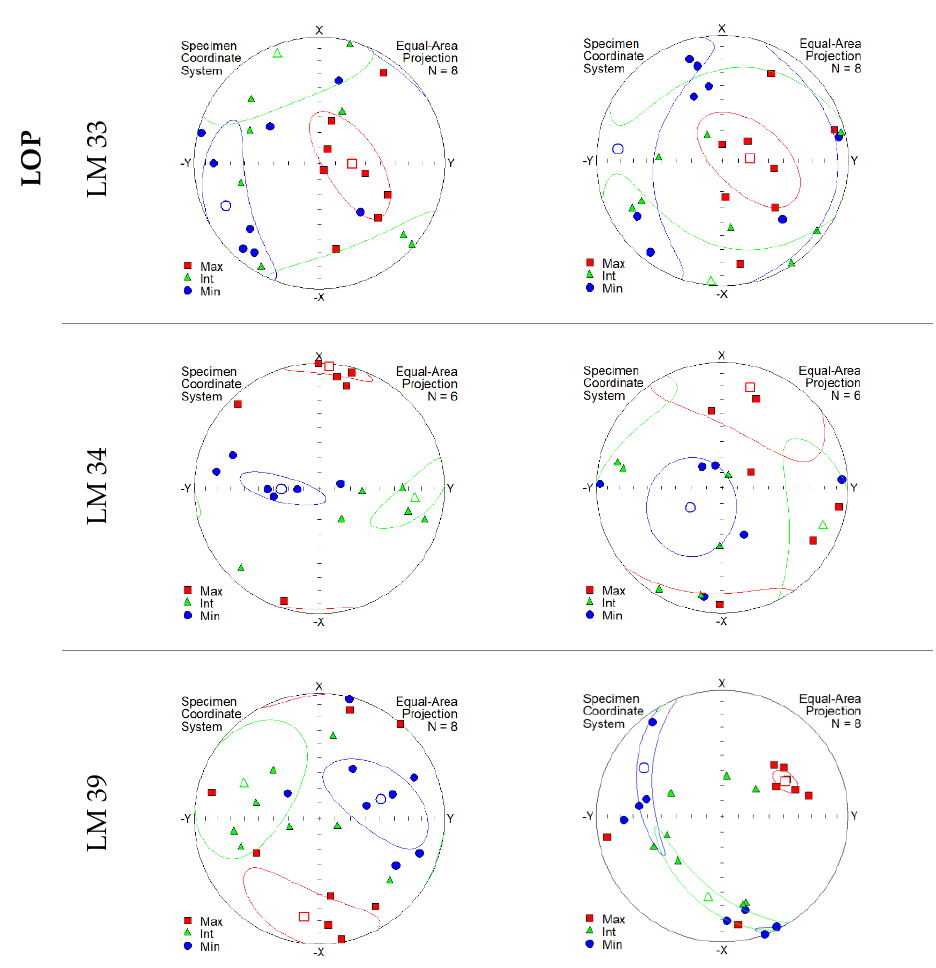
Figure 4. ipAMS and opAMS mean tensors for LOP sub-samples, according to specimen coordinate system, and 95% confidence areas. Equal-area projection, lower hemisphere (the hollow symbols represents the corresponding mean